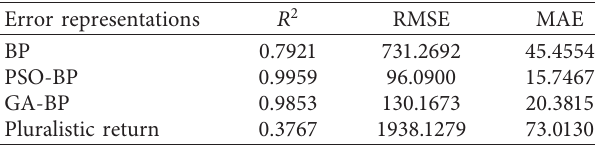
Figure 2: Topological structure diagram of the BP neural network. Table 3: Comparison of three error representations.